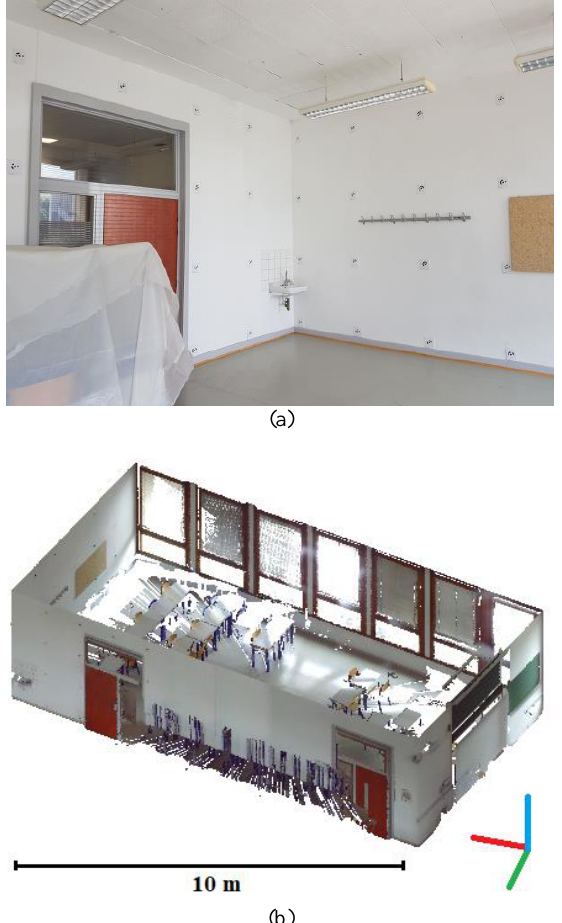
Figure 1. Classroom under study: (a) photograph of the back of the room with targets on walls; (b) laser scanning point cloud